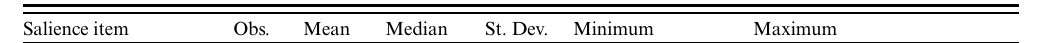
Table 1 . Salience descriptive